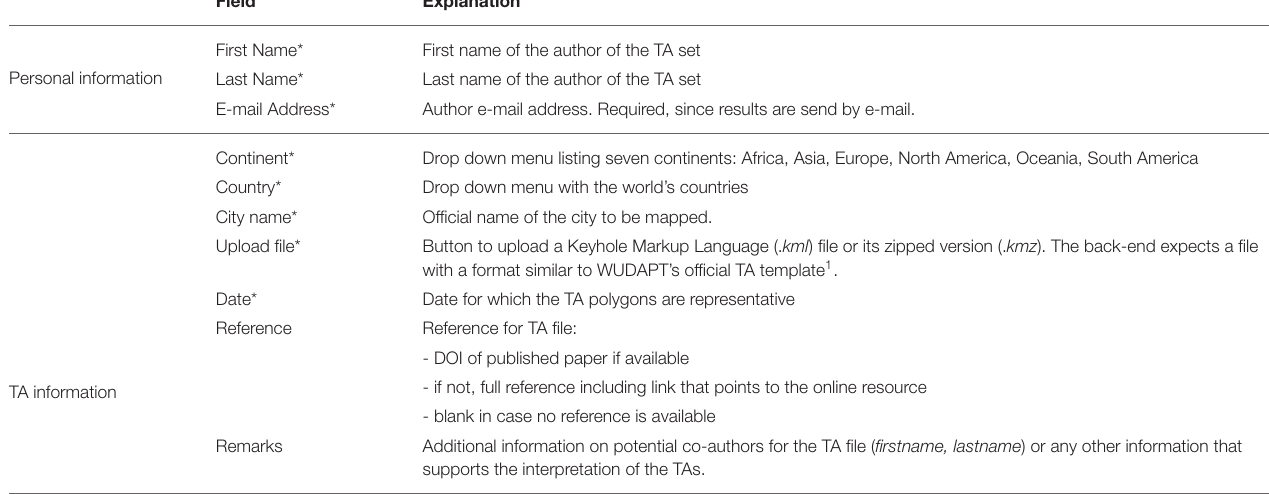
TABLE 1 | Overview of the front-end input